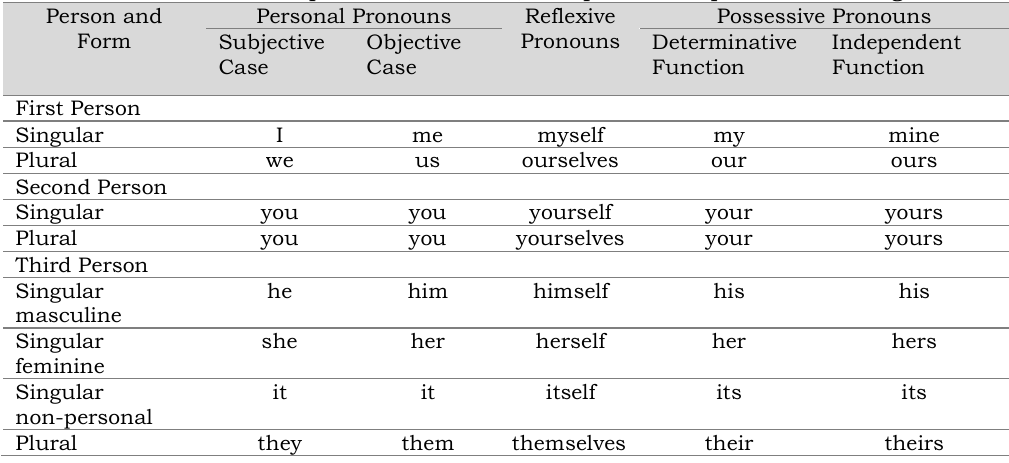
Table 1. The forms of personal, reflexive, and possessive pronouns in English